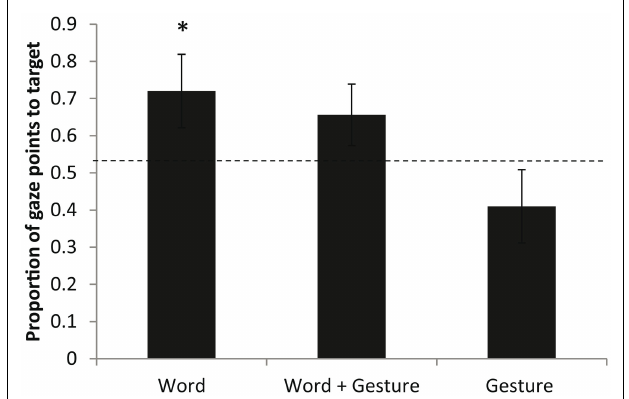
FIGURE 4 | Mean proportions of gaze points to target object relative to the non-target object on trial 1, Question 1. Note: Asterisk indicates significant performance above chance, p <